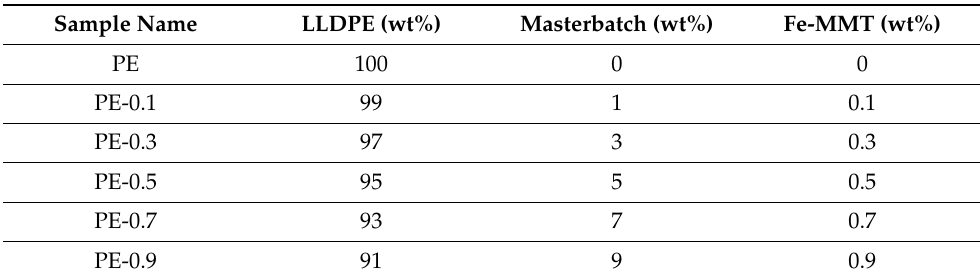
Table 1. Compositions of the sample films used in this work.